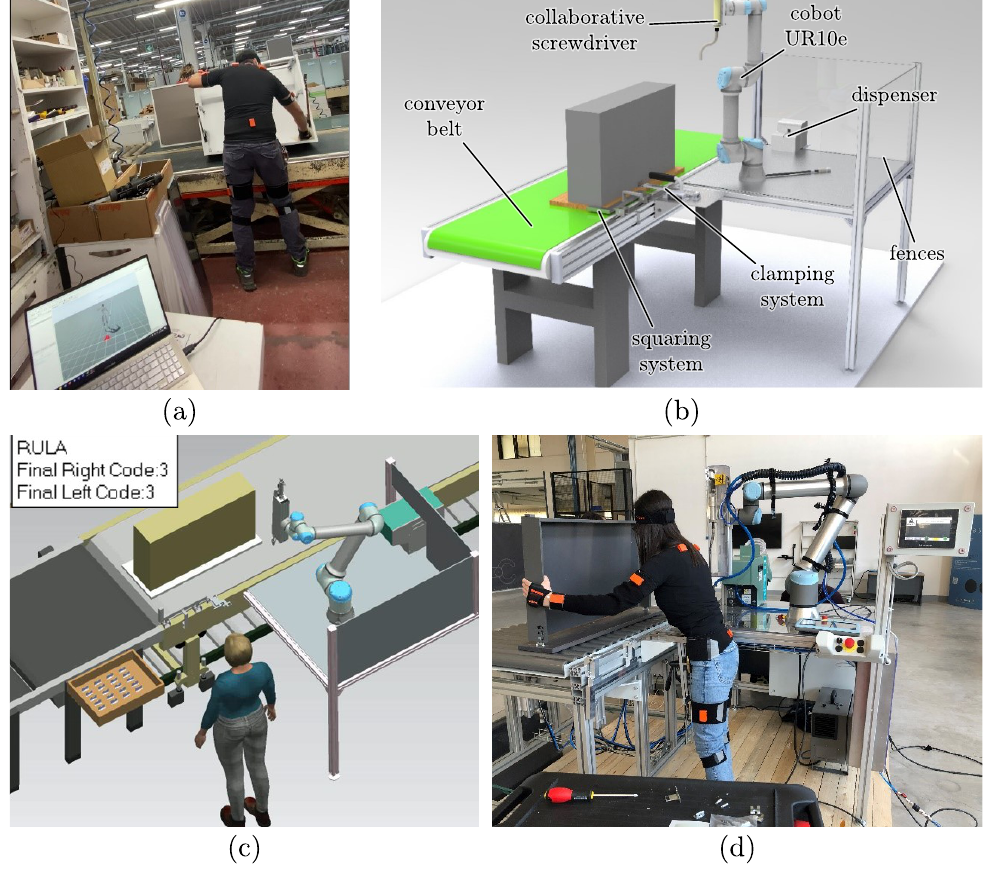
Figure 2. ( a ) human work analysis; ( b ) preliminary concept of cooperative robotic cell; ( c ) HRC simulation; ( d ) physical prototype at